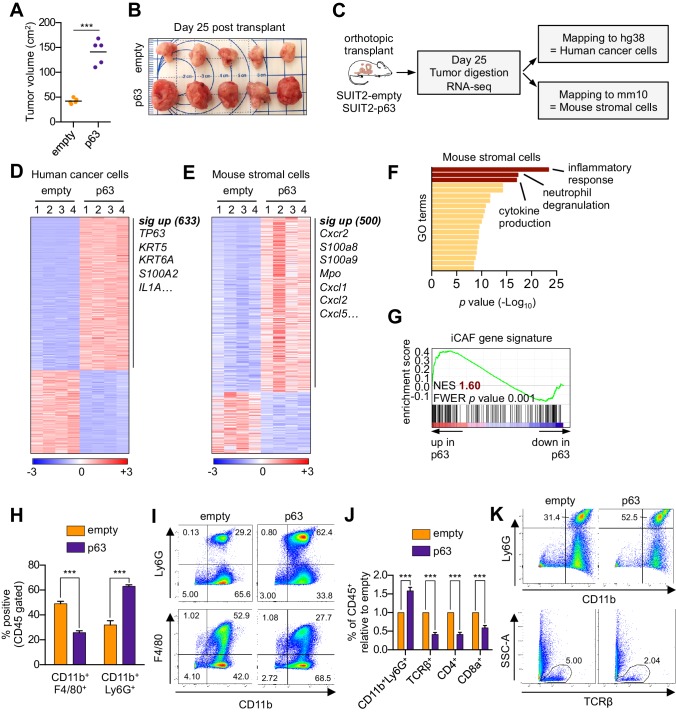
Ectopic expression of p63 in PDA cells promotes inflammation-associated transcriptional changes in the tumor microenvironment.(A–I) SUIT2-empty and SUIT2-p63 PDA cells harboring a luciferase transgene were transplanted into the pancreas of NSG mice. (A–B) Quantification of tumor volume (A) and images of tumors (B) on day 25 post-transplantation. (C) Experimental workflow for RNA-seq analysis of bulk tumor tissue. (D–E) Heatmap representations of differentially expressed genes that unambiguously map to (D) the human genome and therefore are derived from human cancer cells or (E) the mouse genome and therefore are derived from mouse stromal cells. Selected genes in each group are listed. Scale bar indicates standardized expression value. (F) Ontology analysis of the 500 significantly up-regulated mouse genes using Metascape. GO terms are ranked by their significance (p value) and the most significant terms (-log10
p value > 15) are highlighted. (G) GSEA plot evaluating the iCAF signature in the mouse stromal compartment of SUIT2-p63 versus SUIT2-empty tumors. (H) Quantification of flow cytometry analysis of CD45+CD11b+Ly6G+ neutrophils and CD45+CD11b+F4/80+ macrophages from bulk tumor tissues from SUIT2 xenografts. n = 5 mice per group. ***p<0.001 by Student’s t-test. (I) Representative flow cytometry plots from (H). (J–K) KPC mM1 organoids with a p63 cDNA or empty vector control and transplanted to the pancreas of C57BL6 mice. (J) Quantification of flow cytometry analysis of CD45+ cells in the tumors. n = 4–5 mice per group. ***p<0.001 by Student’s t-test. (K) Representative flow cytometry plots from (J). TCRβ refers to T cell receptor β.